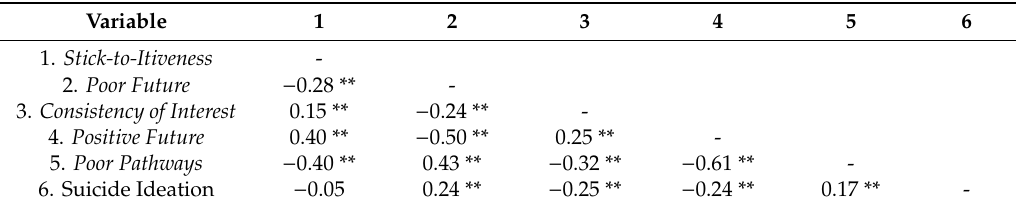
Table 5. Correlation Coe ffi cients, Means, and Standard Deviations of the Five Retained Factor Scores and Predictors of Suicide Ideation.